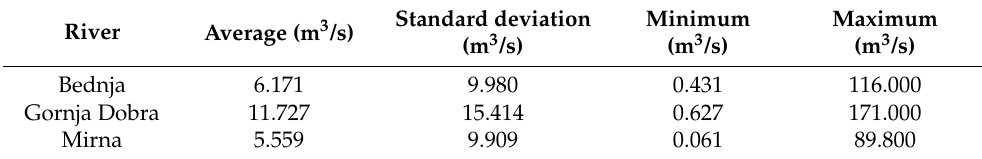
Table 1. Statistical parameters of the average daily flows for the Bednja, Gornja Dobra, and Mirna rivers during 20-year observation